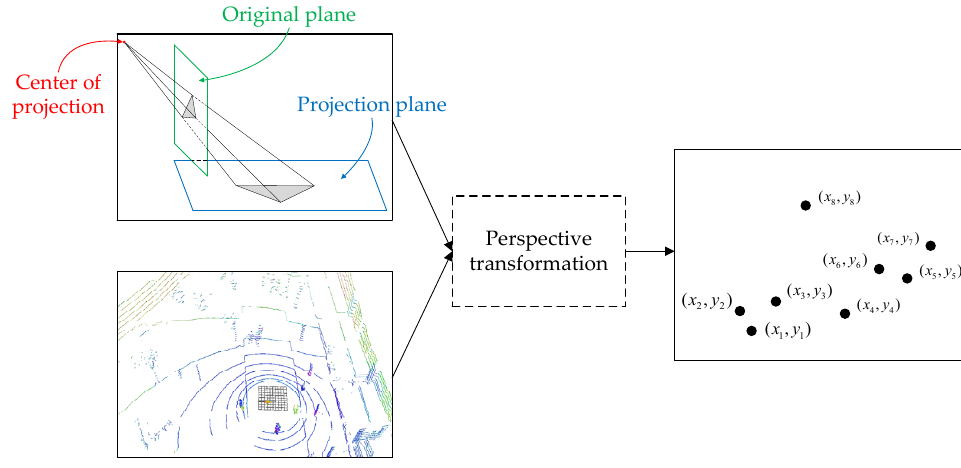
Figure 7. Structure of perspective transformation.